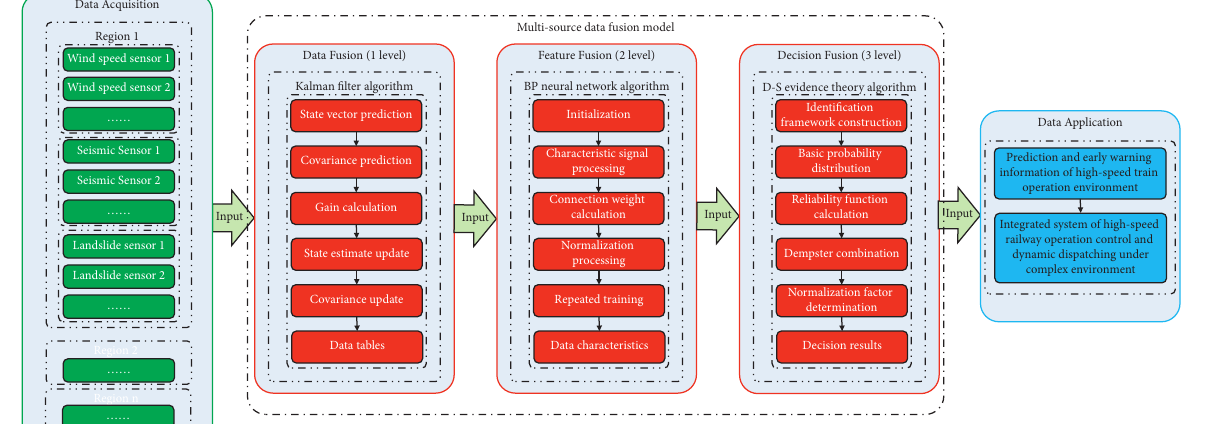
Figure 2: Multisource data fusion model of complex